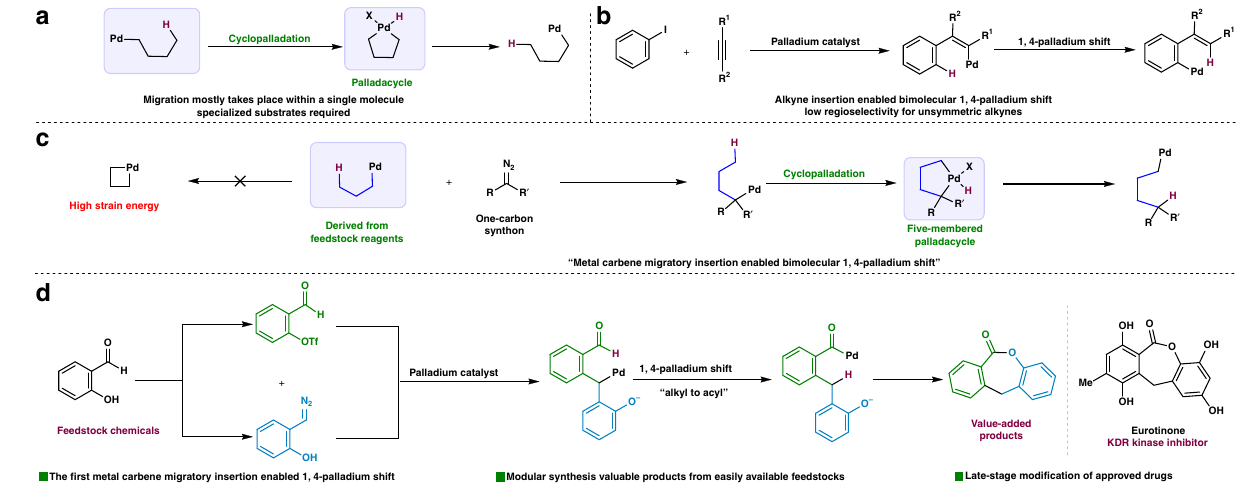
Fig. 1 Reaction modes for palladium-catalyzed C – H bond functionalization. a Reaction mode for 1,4-palladium shift. b Alkyne insertion-enabled 1,4- palladium shift. c Proposed metal carbene migratory insertion-enabled 1,4-palladium shift. d Working hypothesis for seven-membered lactone